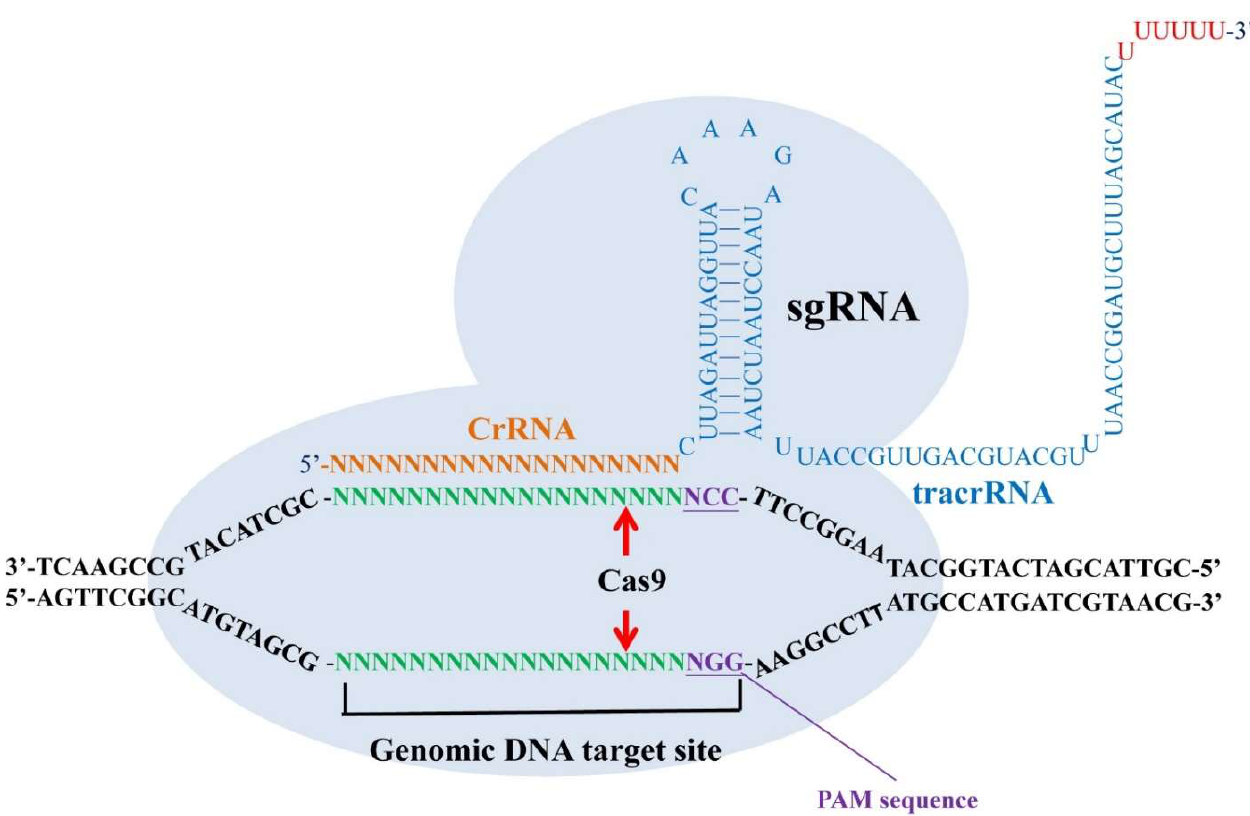
Figure 1. A single guide RNA (sgRNA) which is composed of clustered, regularly-interspaced short palindromic repeats (CRISPR) RNA (crRNA) and transactivating crRNA (tracrRNA) can recognize their target DNA sequence and allow the Cas9 protein to cleave 3 bp upstream of the protospacer adjacent motif (PAM) sequence (NGG) in both sense strand and antisense strand. The specific binding of sgRNAs and the cleavage of Cas9 endonuclease make a double-stranded break (DSB) with blunt ends in their genomic target sites.